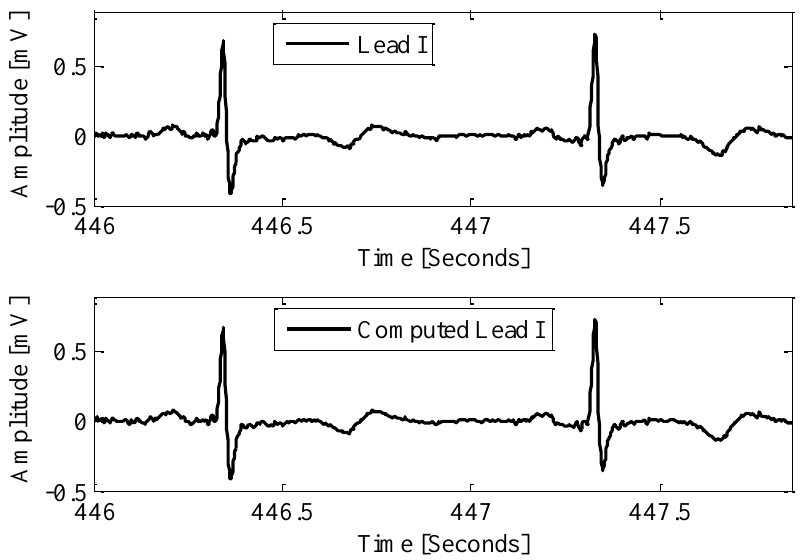
Figure A1. Example reconstruction of limb leads from components (P016). In this example, we reconstructed (computed) lead I from the LA and RA potentials recorded by our hardware; correlation between signals scored in excess of 99%.